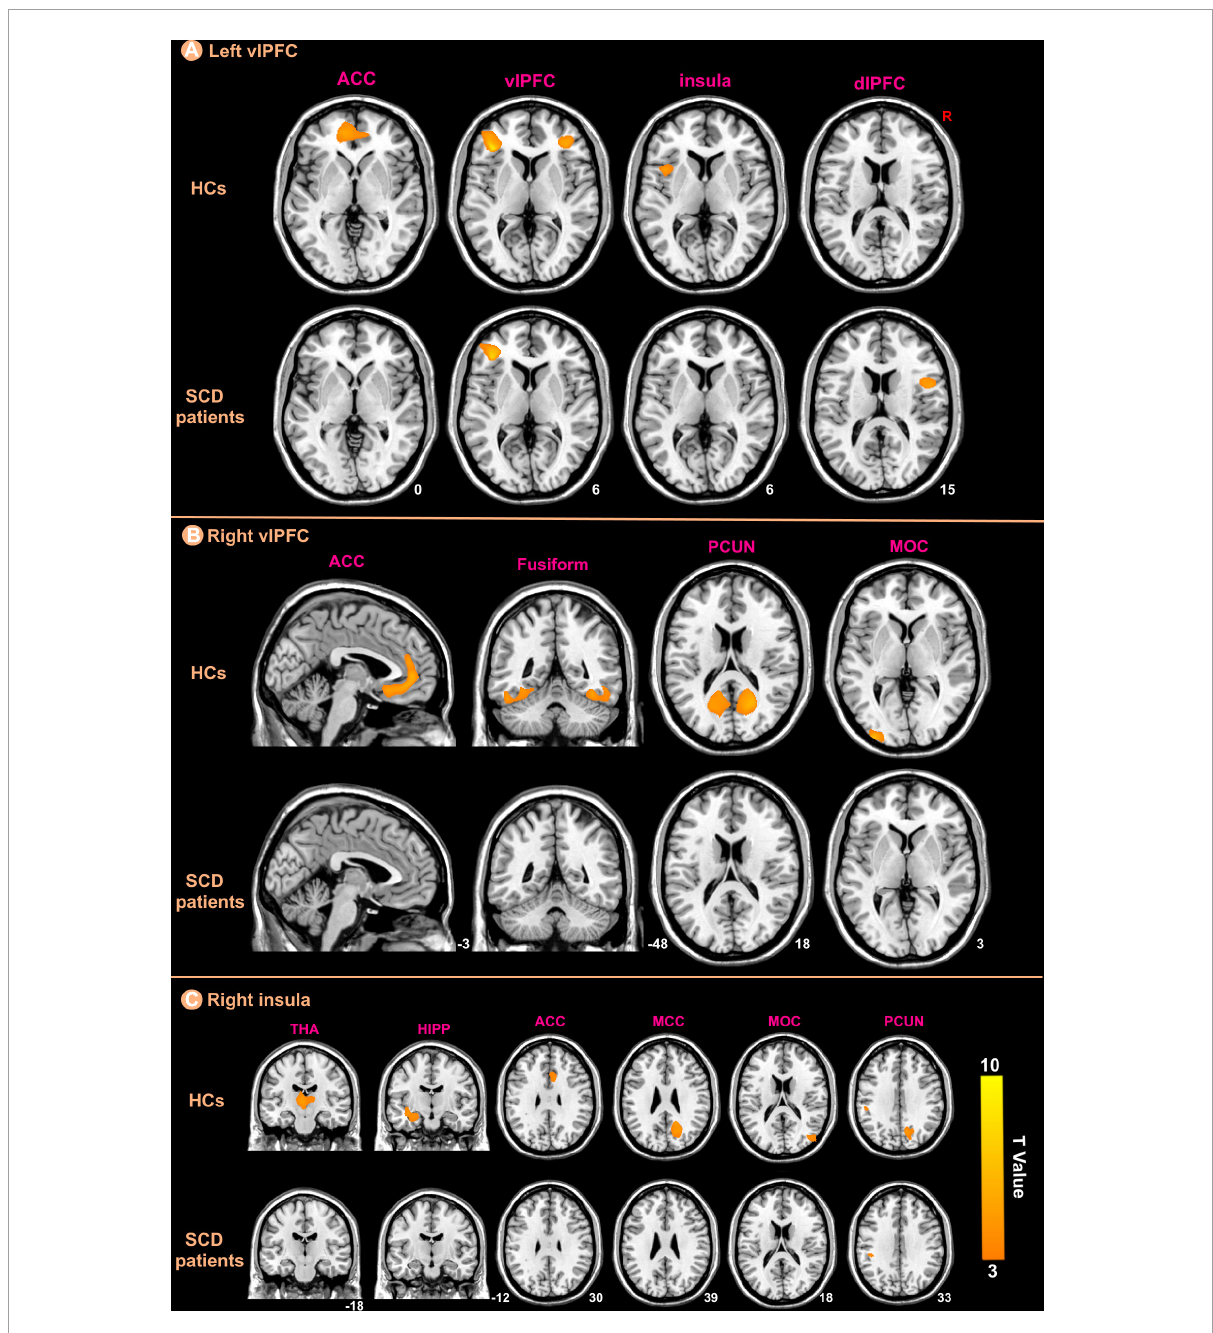
FIGURE5 The ROIs-based structural covariance patterns in subjective cognitive decline (SCD) patients and healthy controls (HCs). The structural covariance patterns related with the left vlPFC (A) , the right vlPFC (B) , and the right insula (C) ROIs in the two groups.